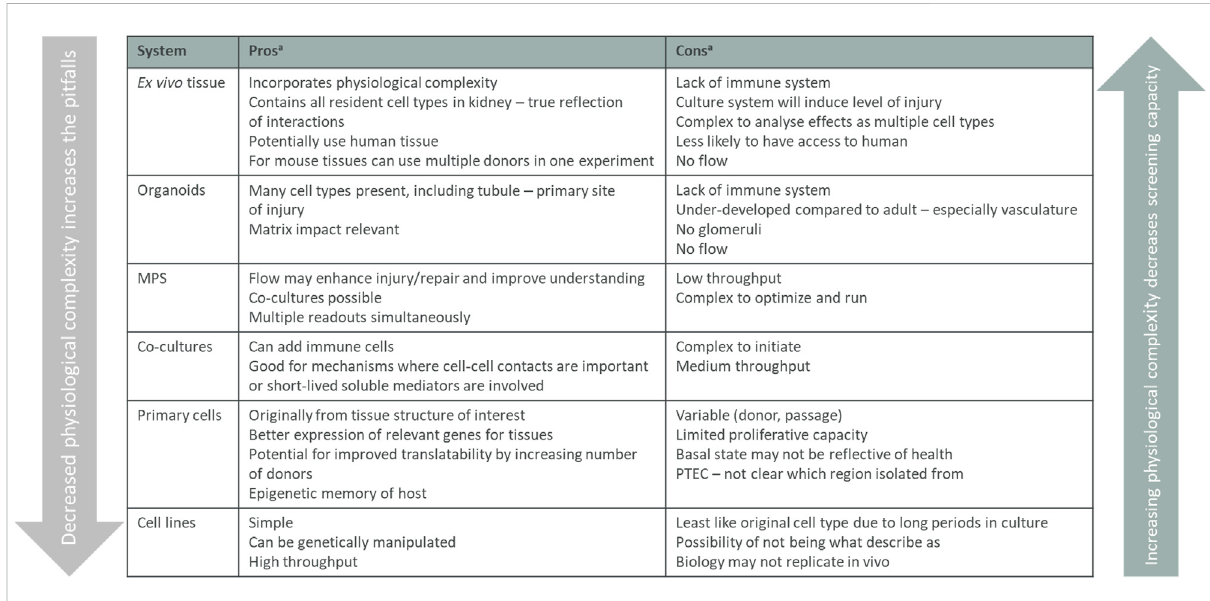
FIGURE 4 Summaryof invitro validationmodels.Listed invitro modelsarrangedfromtheassaycontainingthemosttissuecomplexitydowntosinglecells, listing the pros and cons for the different models. The physiological complexity of the different models impacts both the screening capacity of the assay and what biology that translates. MPS, micro-physiological systems. a considerations are listed in a step-wise manner and main considerations only are